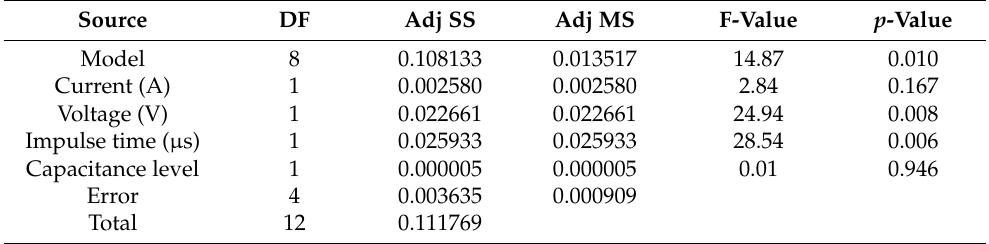
Table 9. Statistical analysis (ANOVA) of the influence of machining parameters on taper